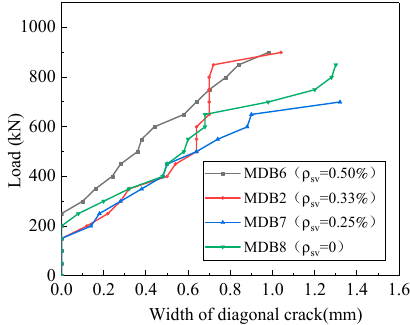
Figure 21. Relation curve between ρ sv and maximum crack width.